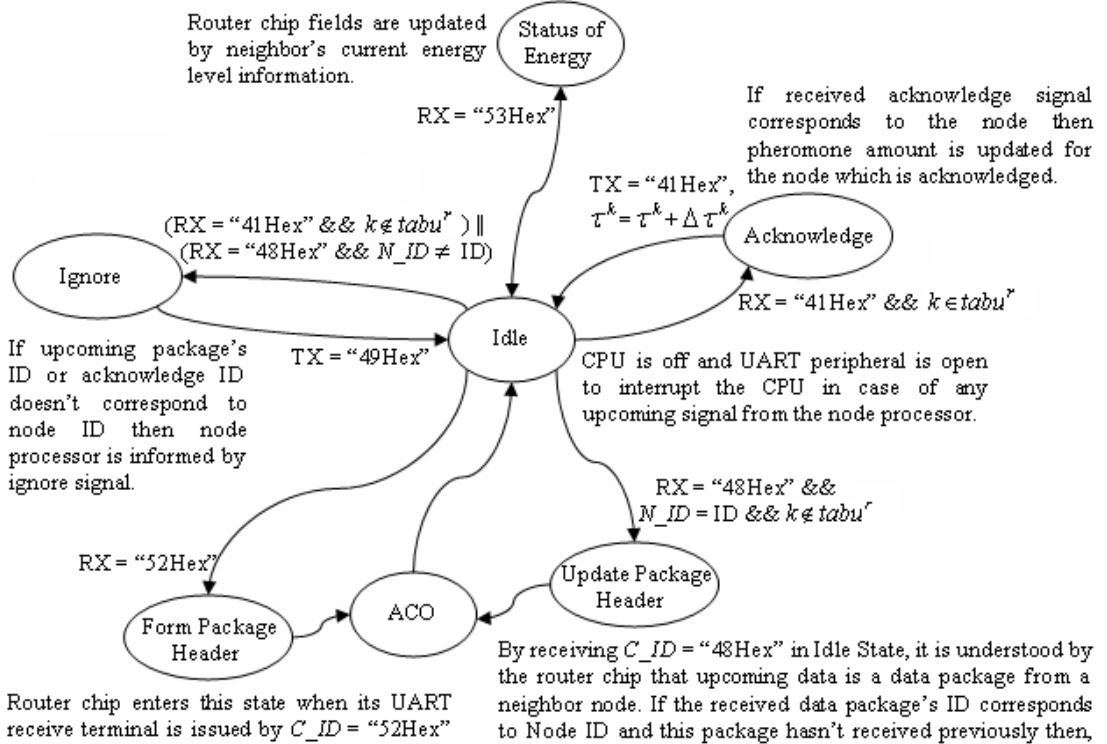
Figure 8. State Diagram of Communication Protocol.